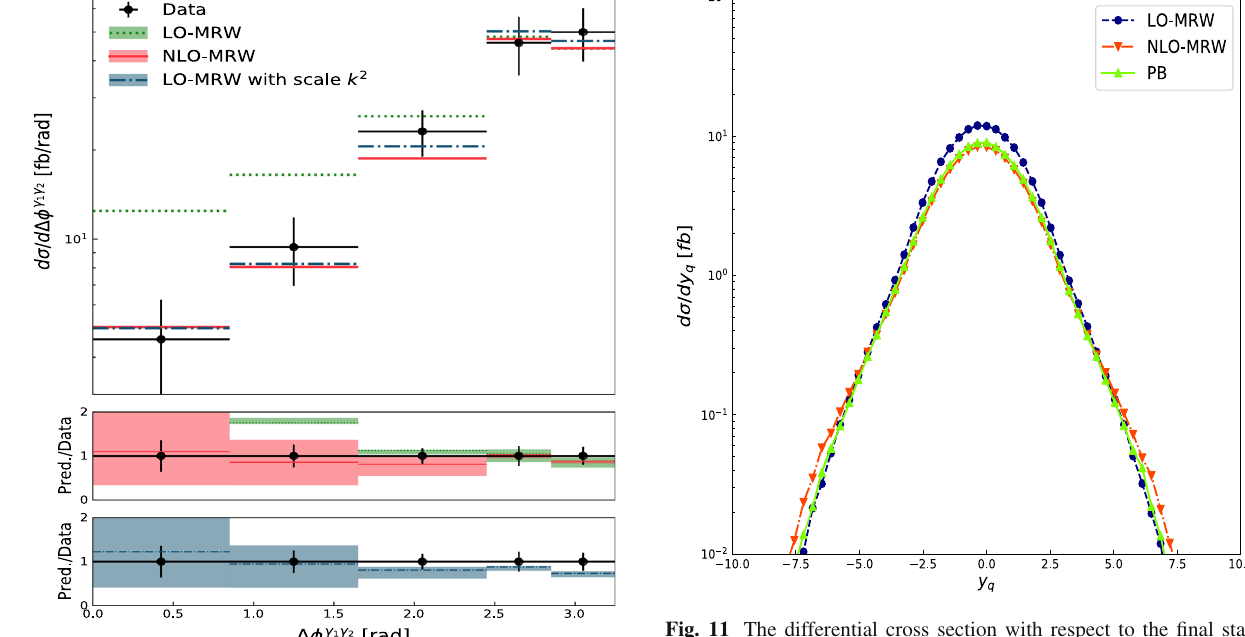
Fig. 11 The differential cross section with respect to the final state quark rapidity ( y q ) for the different UPDFs defined in the